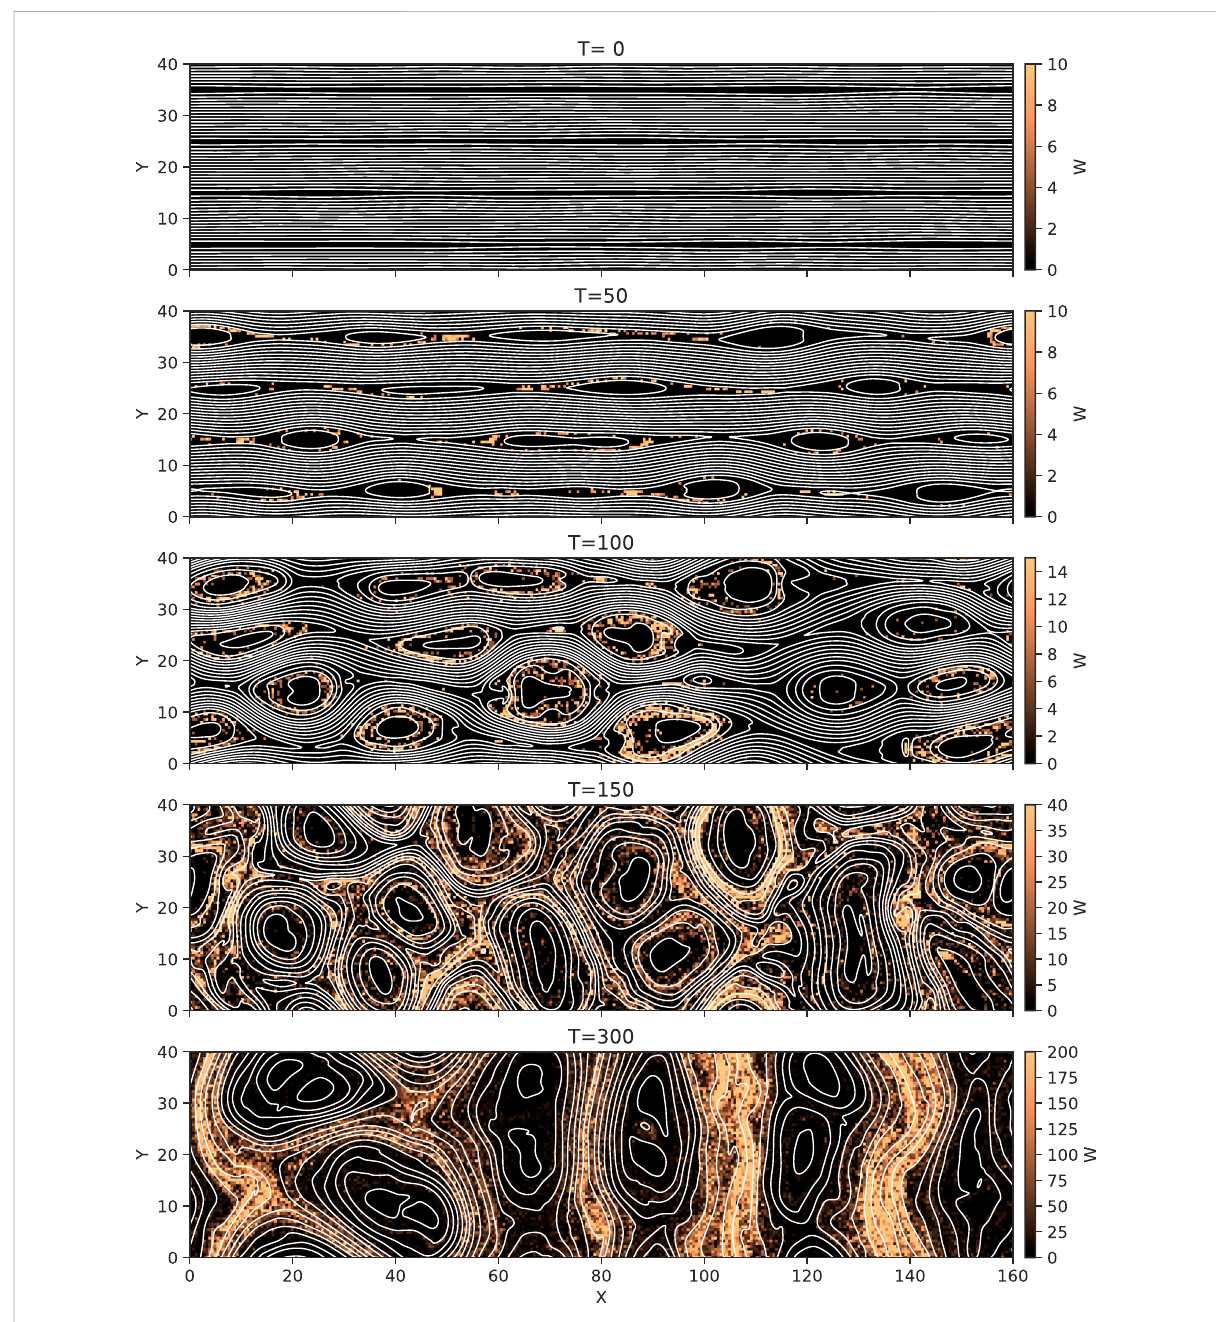
FIGURE 4 Snapshots of the energy density of particles de fi ned by W (cid:2) (cid:20) ∞ E corresponds to the magnetic fi eld